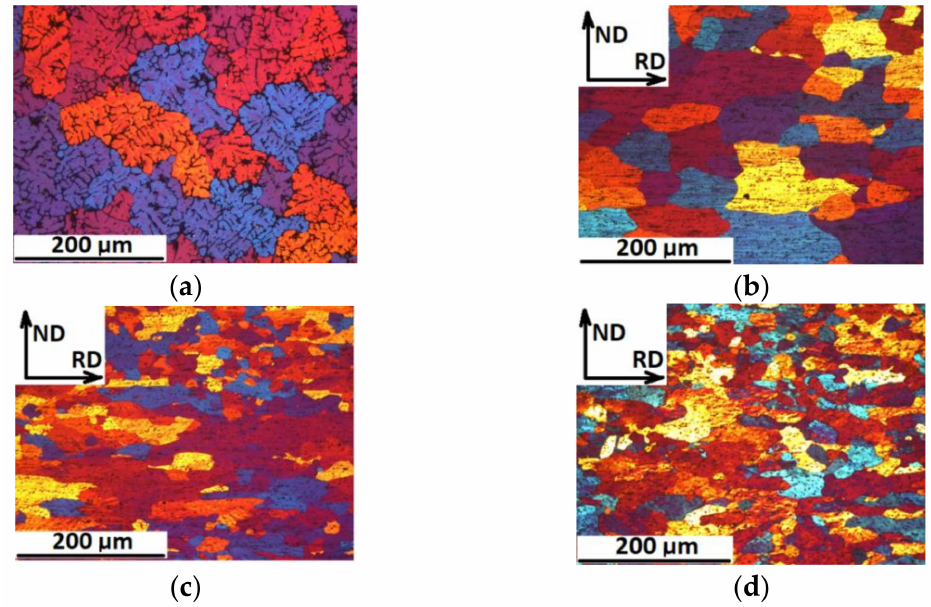
Figure 4. Microstructure of 8011 alloy specimen: ( a ) cast specimen, ( b ) 29.82% deformation, ( c ) 63.16% deformation, ( d ) 80.70%